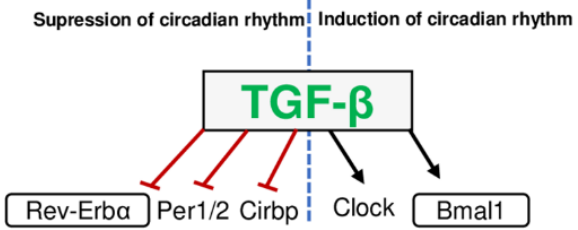
Figure 5. TGF- β inhibits the expression of the negative regulators of circadian clocks ( Rev-Erb α / β , Per1/2 , Cirbp ) and prolongs the wake period. In addition, TGF- β reverses the wake period by stimulation of Clock and Bmal1 expression.